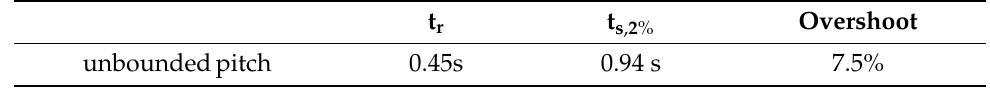
Table 1. Representative values of height control for